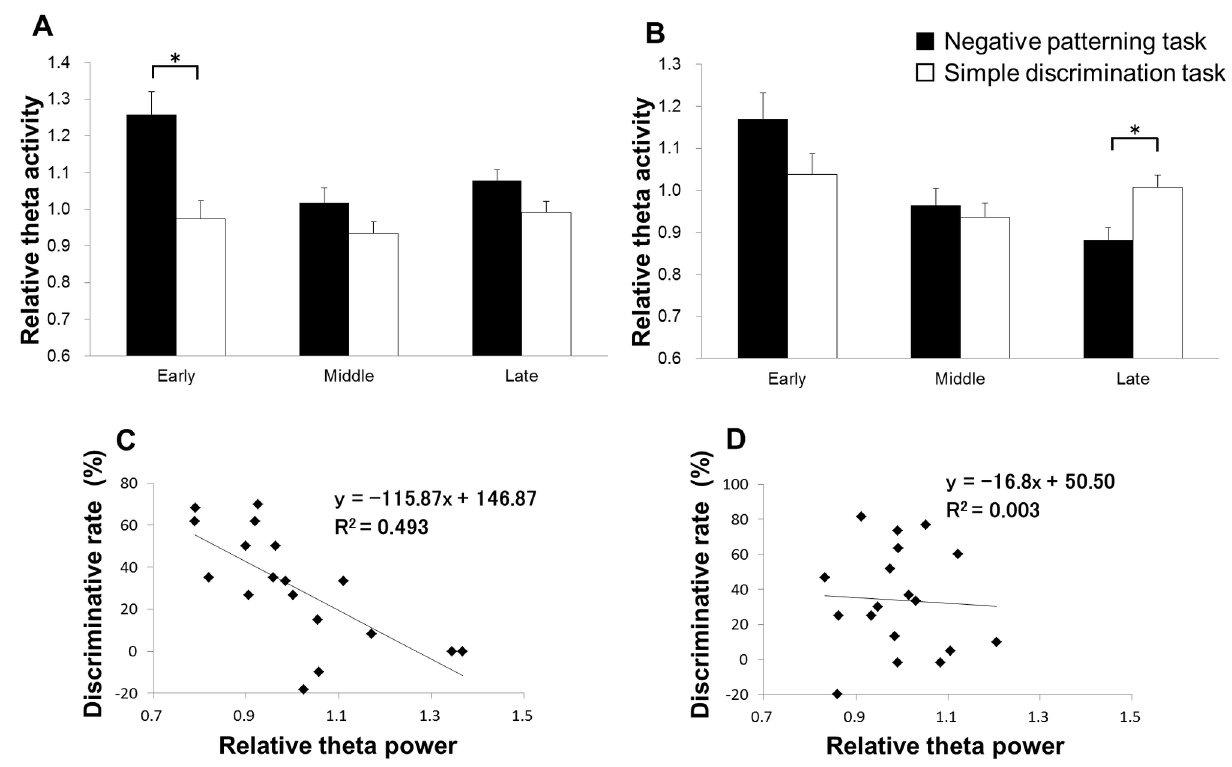
Figure 6. A comparison of the mean relative hippocampal theta activity between tasks. Panel A shows the relative hippocampal theta power during the 250-ms and Panel B does during 500-ms epochs between the negative patterning and simple discrimination task groups. A group (negative patterning task and simple discrimination task groups) × stage (early, middle, and late) ANOVA for hippocampal theta activity during a 250-ms epoch in the non-RFTs showed a significant interaction ( F = 5.18, p < (2,20) 0.05). Multiple comparisons revealed that hippocampal theta power increased during the early stage in the negative patterning task compared to the simple discrimination task group ( p < 0.05). A group (negative patterning task and simple discrimination task groups) × stage (early, middle, and late) ANOVA for hippocampal theta activity during a 500-ms epoch in the non-RFT showed a significant interaction ( F = 6.12, p < 0.05). Multiple comparisons revealed that hippocampal theta power decreased during the (2,20) late stage in the negative patterning task compared to the simple discrimination task group ( p < 0.05; *: p < 0.05). Hippocampal theta power during the 500 ms non-RFT correlated with the discrimination rate in the negative patterning task ( r = -0.70, p < 0.05; panel C), but not the simple discrimination task ( r = -0.06, p = n.s ; panel D).